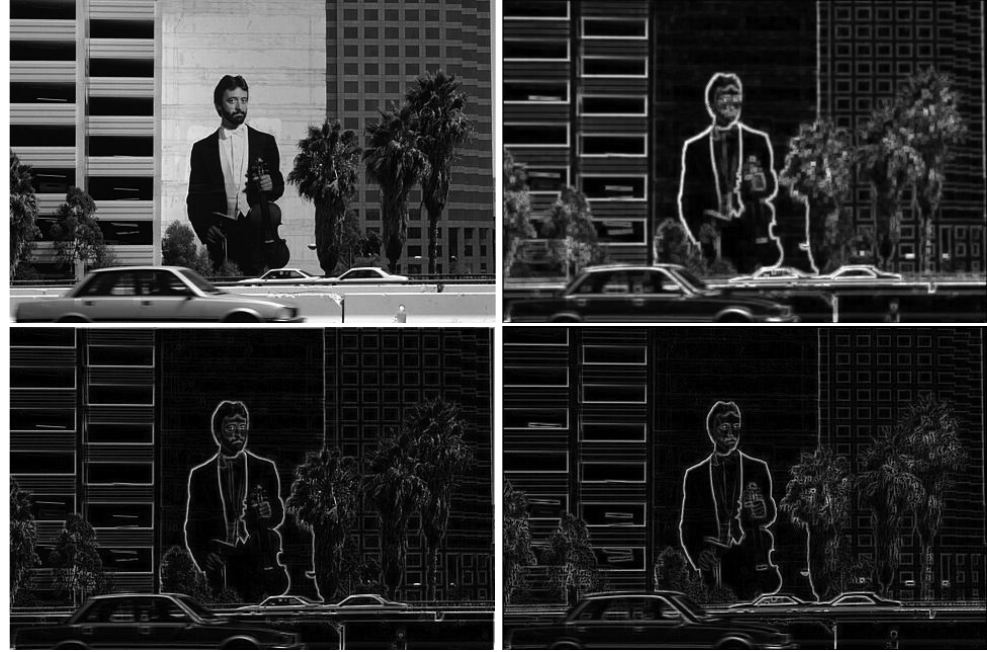
Figure 1: Original image (top left), gradient (top right), internal gradient (bottom left) and external gradient (bottom